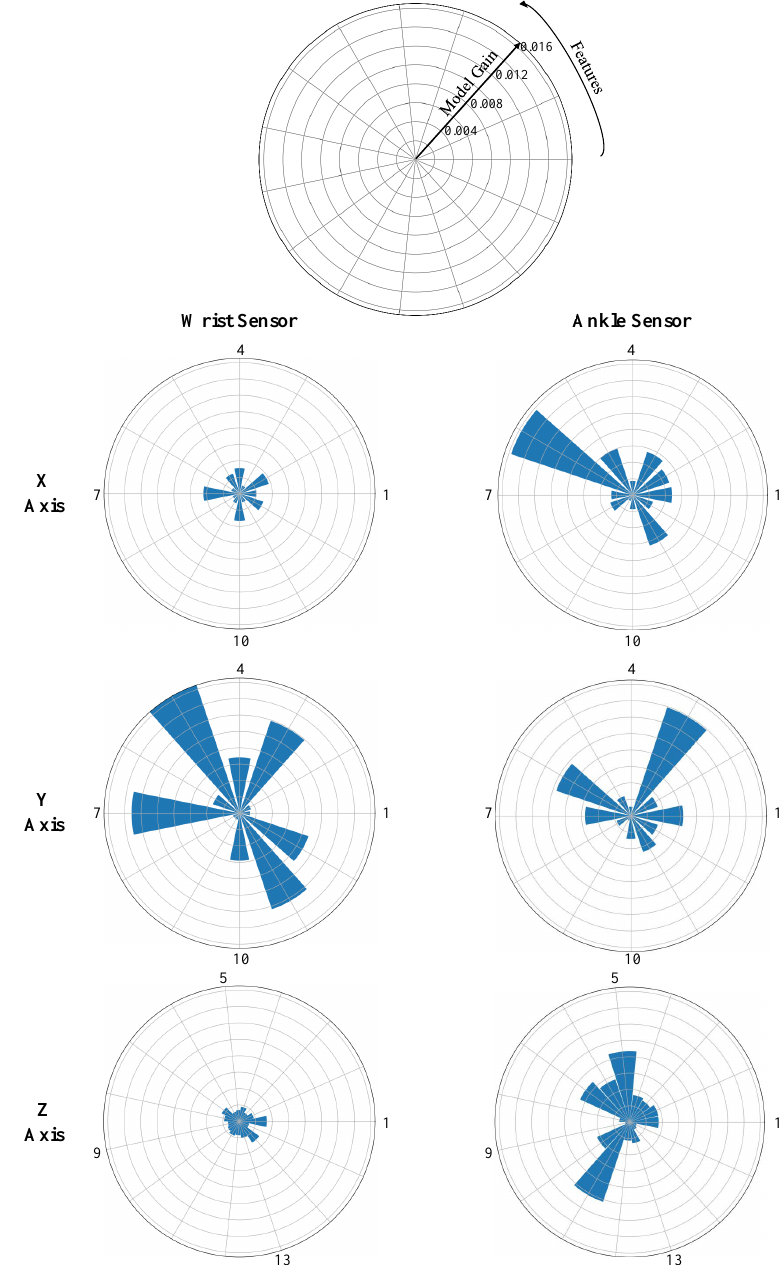
Figure 5. Feature importance based on the ensemble model gain. Each radar plot represents the gain using the features extracted from specific axis and specific sensor. The numbers correspond to each of the features (refer to Table